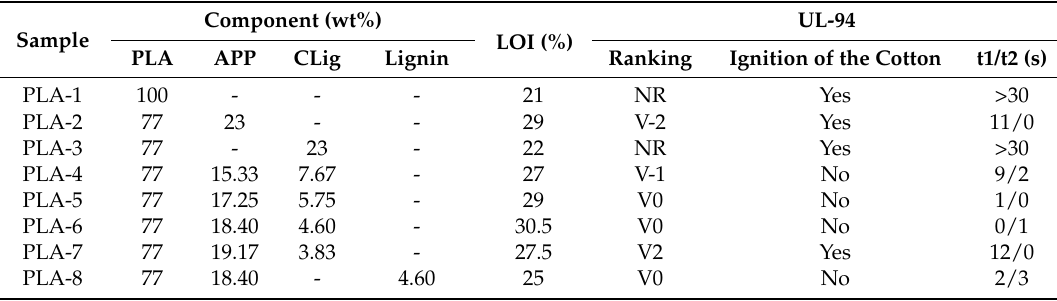
Table 1. Composition of the samples and the testing results of neat PLA and PLA composites’ LOI and UL-94 vertical burning.